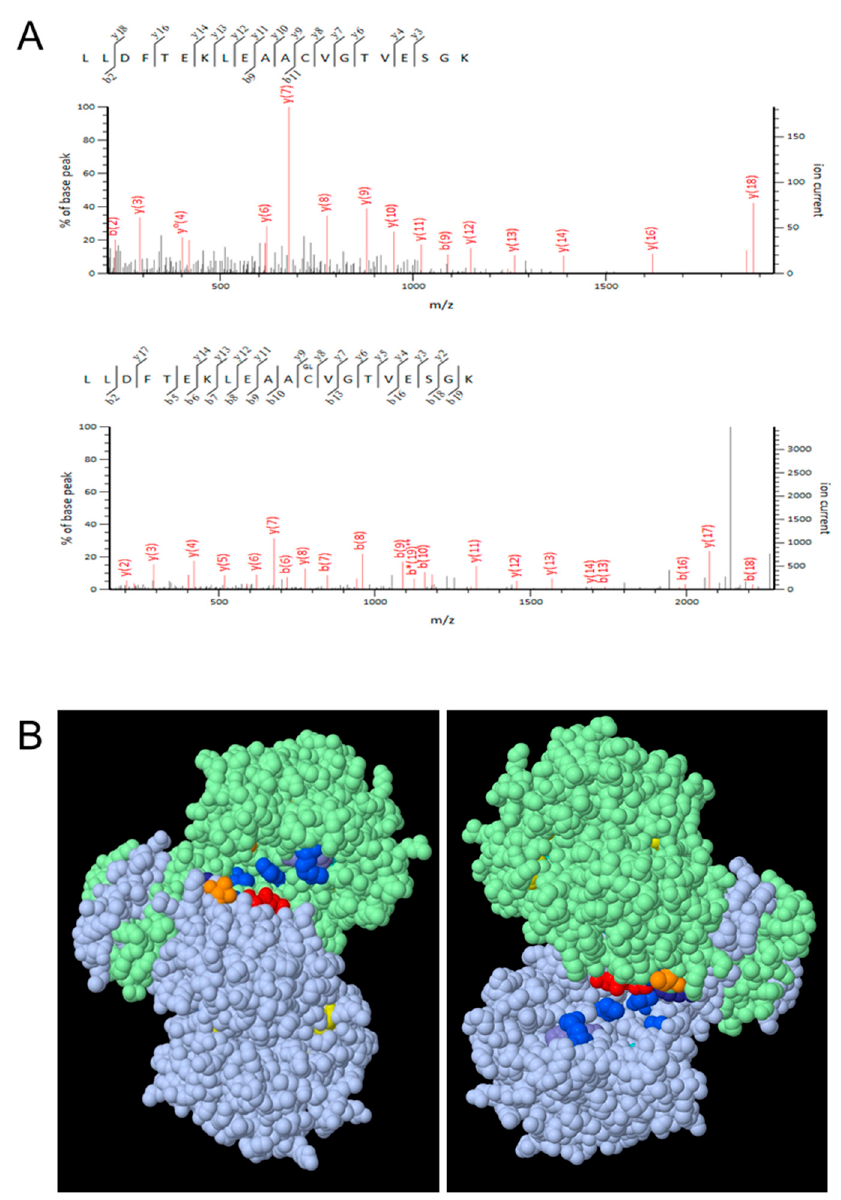
Figure 3. Glutathionylation of cICDH. ( A ) cICDH was treated or not with 1 mM GSNO for 30 min at 25 ◦ C. Samples were trypsin digested and analyzed by nanoLC-MSMS. The panels show fragmentation spectra matching peptides with either unmodified (top) or with glutathionylated C363 (bottom). The same glutathionylated residue was identified in three biological repetitions. ( B ) Modeled cICDH (residues 4–408) homodimer (grey and green chains) based on human cytosolic ICDH. Conserved amino acids (R111, R134, Y141, T214, D252, D279, R314, H315) with the most plant and mammalian NADP-ICDH proteins, in the active site pocket are shown in different colors depending on the nature of the residue: R, blue; Y, purple; T, orange; D, red; H, grey. The conserved cysteine C363 in each chain is represented in yellow (arrowheads). In the right panel, the cICDH homodimer was rotated 180 ◦ .